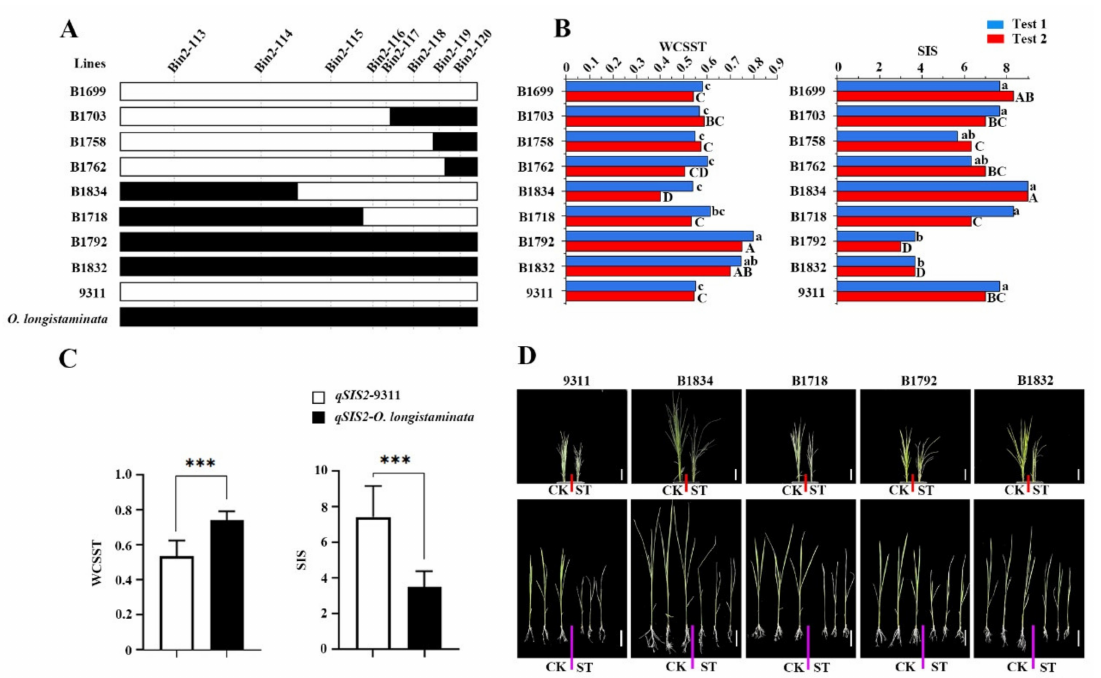
Figure 4. Validation of the function of qWCSST2/qSIS2/qRWCS2 . ( A ) Genotype of the representative BIL lines. ( B ) Phenotypic value corresponding to BILs. ( C ) Average of the WCSST and SIS value of the representative BIL lines with and without qWCSST2/qSIS2/qRWCS2 . The white rectangle shows the homozygous genotype from parent 9311, including BIL 1699, 1703, 1758, B1762, 1834, 1718. The black rectangle indicates the heterozygote genotype, and contains BIL 1792 and 1832. *** p < 0.001. ( D ) The phenotype of the representative BILs and the parent 9311, bar = 5 cm. The red and purple lines separate control and salt-treated seedlings, with the control seedlings on the left and the salt-treated seedlings on the